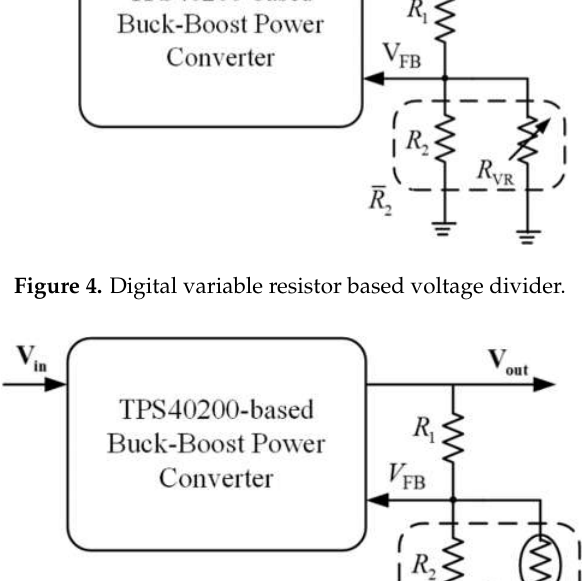
Figure 5. Light dependent resistor (LDR) based voltage divider.